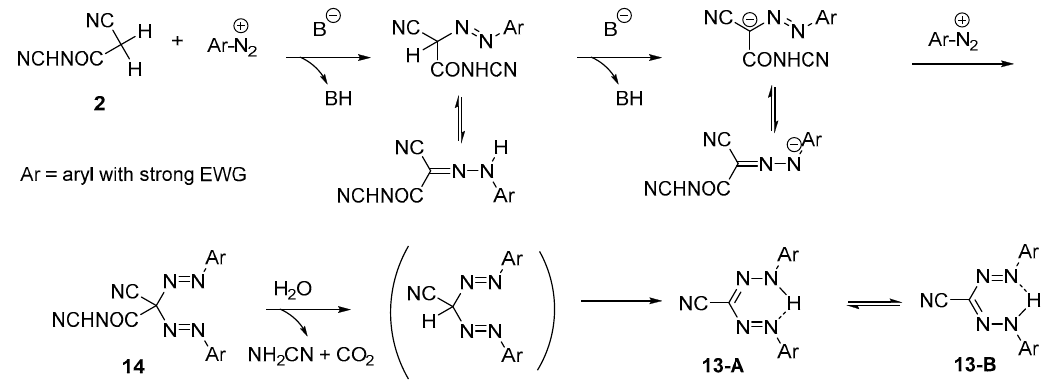
Scheme 2. Plausible mechanisms for formazan 13 formation in the reaction of reactive diazonium salts with 2-cyanoacetylcyanamide 2 under basic